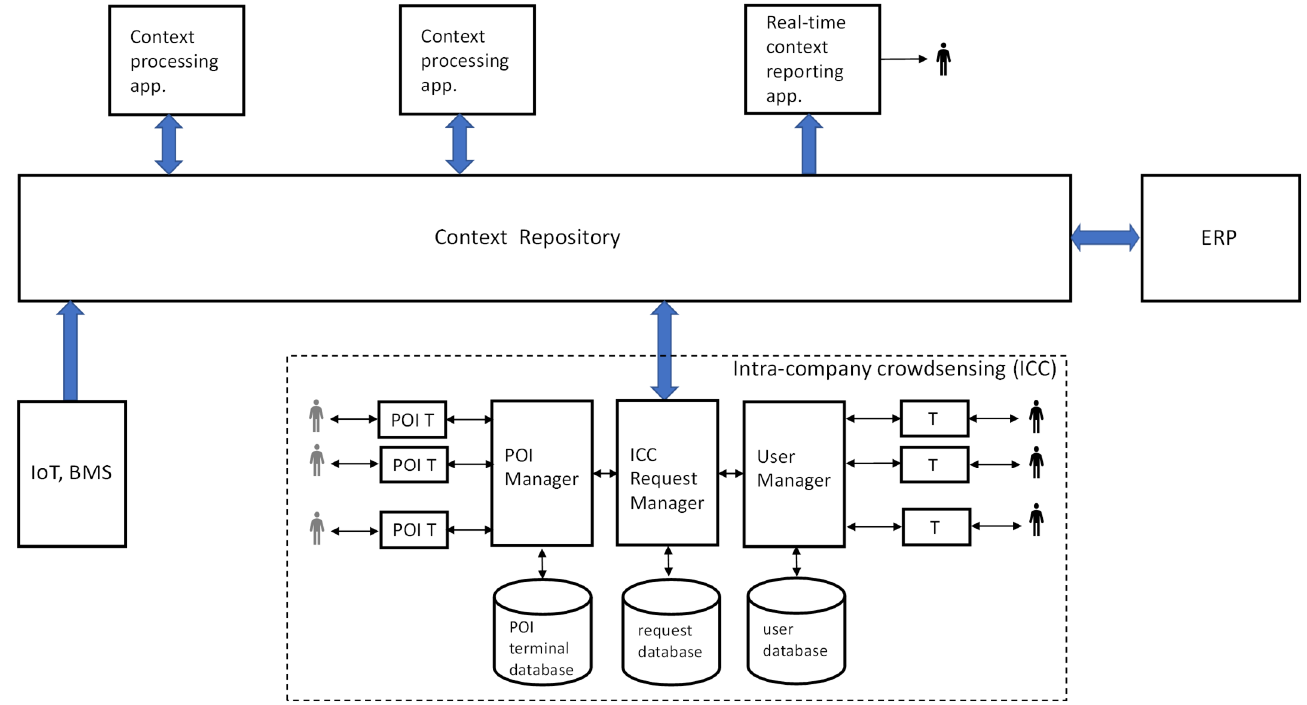
Figure 2. An ICC sub-system integrated with a context-aware system.